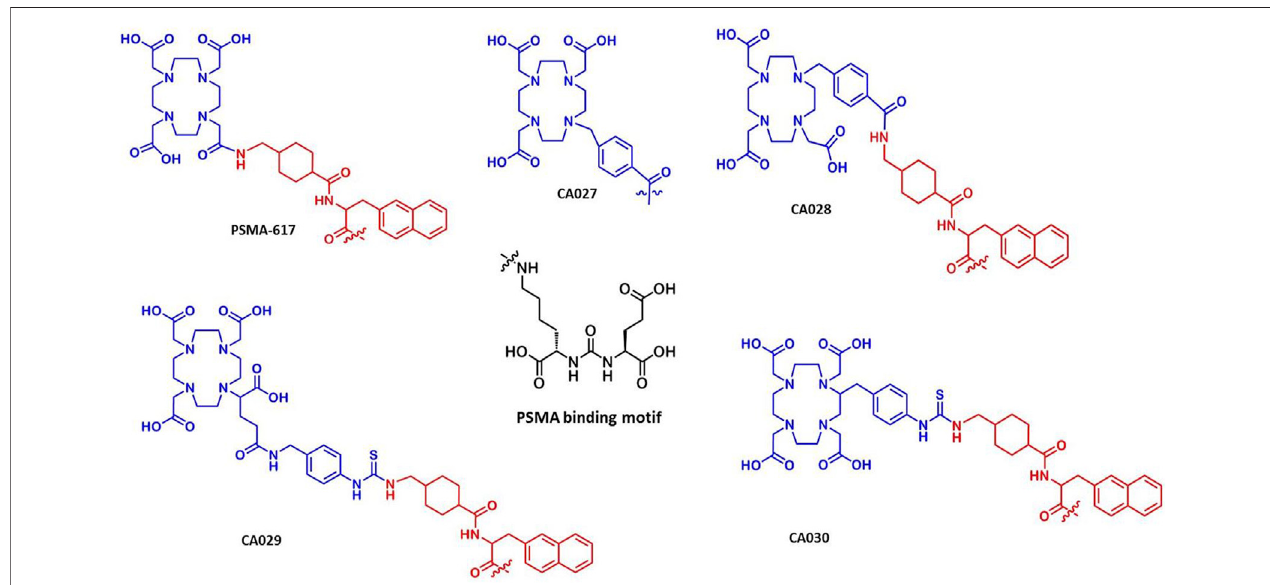
FIGURE 1 | Chemical structures of the novel PSMA ligands in comparison with the reference compound PSMA-617. The ligands comprise the PSMA-speci fi c urea-based binding motif, the linker, as compared to the reference PSMA-617.